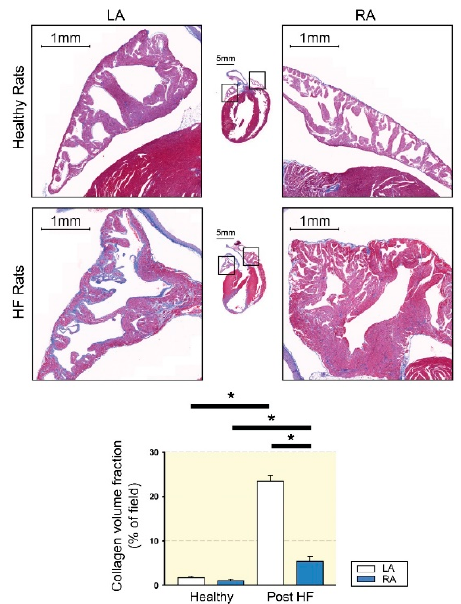
Figure 1. Atrial fibrosis of left atrium (LA) and right atrium (RA) tissues from healthy and heart failure with reduced ejection fraction (HF) rats. The upper photographs show representative photos with Masson’s trichrome staining of healthy LA and healthy RA atrial fibrosis. The lower photographs show representative photos of HF LA and HF RA atrial fibrosis. Compared to HF RA, HF LA exhibited greater levels of atrial fibrosis. LA and RA from healthy rats revealed a similar extent